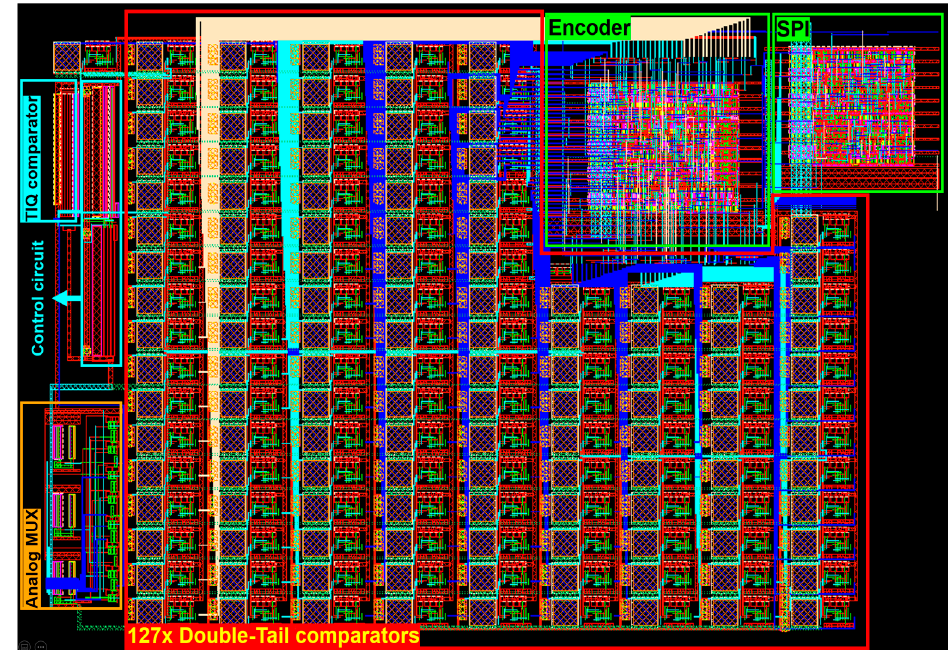
Figure 16. The layout of the flash ADC.